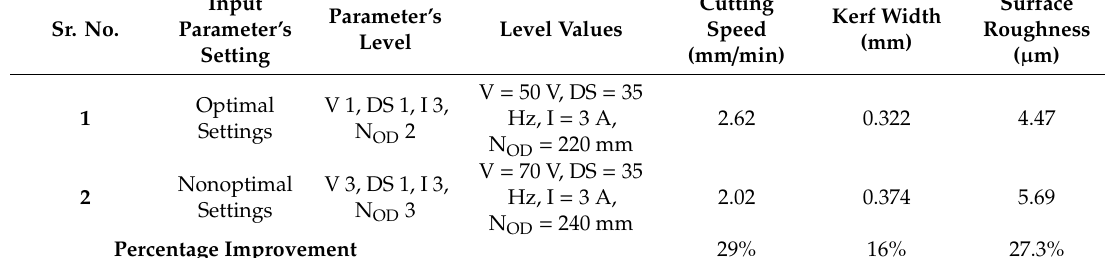
Table 5. Results of confirmatory test.